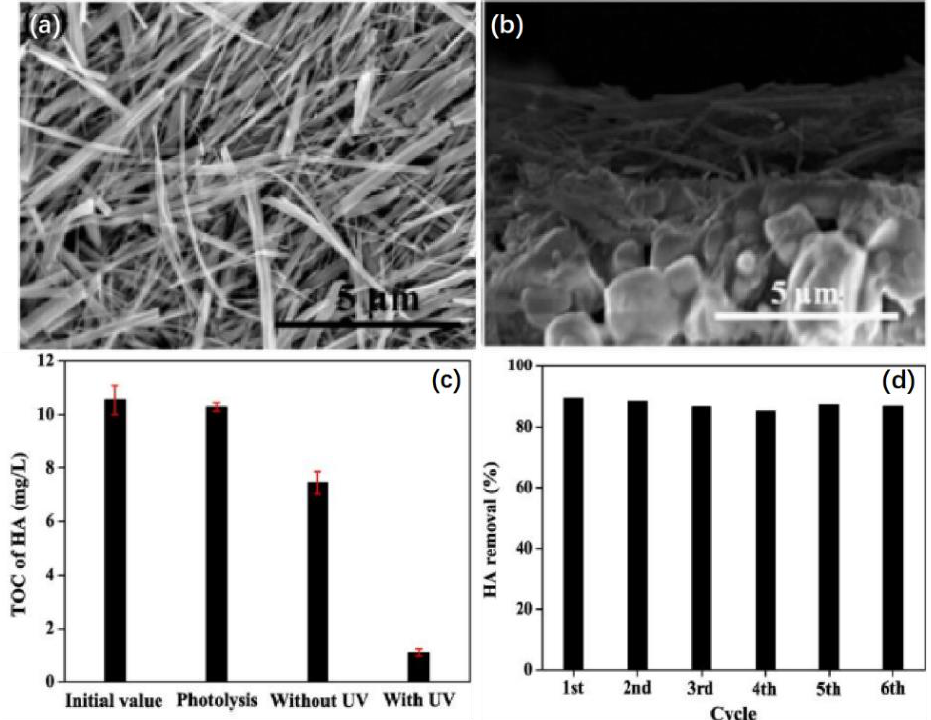
Figure 4. ( a ) Scanning electron microscopy (SEM) image of TiO 2 nanofibers synthesized by the hydrothermal method. ( b ) SEM image of ceramic hollow membranes coated with TiO 2 nanofibers. ( c ) Total organic carbon (TOC) removal using TiO 2 nanofiber membranes. ( d ) Reusability of the TiO 2 nanofiber membranes for hyaluronic acid removal. Copyright © 2015 Elsevier B.V.